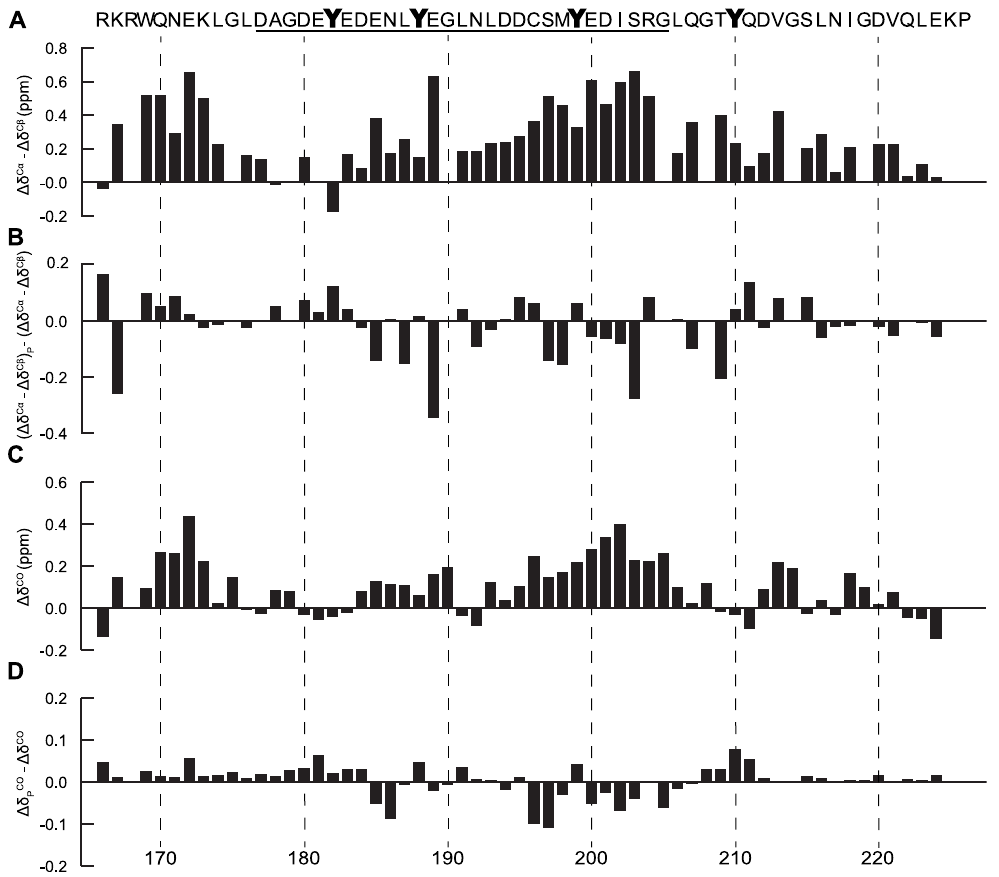
Figure 2. Secondary structure propensity of CD79a and the effects of phosphorylation. The ITAM region in the sequence is underlined and all shifts are plotted against their corresponding residue number ( A ) ( Dd C a – Dd C b ) secondary chemical shifts. CD79a has an overall tendency for a - helical structure with an increased propensity in the regions Arg166 to Gly175 and Asp194 to Gly205. ( B ) ( Dd C a – Dd C b ) P –( Dd C a – Dd C b ) secondary chemical shifts. Negative values in the C-terminal part of the ITAM indicate decreased helicity in this region following phosphorylation. ( C ) Dd CO secondary chemical shifts. The Dd CO shift pattern agrees well with the pattern of ( Dd C a – Dd C b ) indicating an overall tendency for a -helical structure ( D ) ( Dd PCO – Dd CO ) secondary chemical shifts. Phosphorylation decreases the tendency for a -helical structure in the C-terminal part of the ITAM